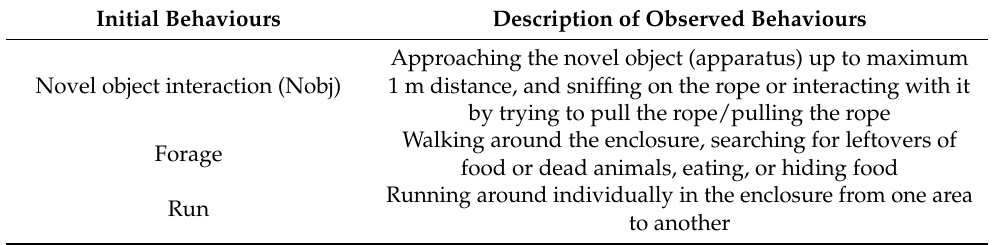
Table 3. Definitions of initial behaviours.